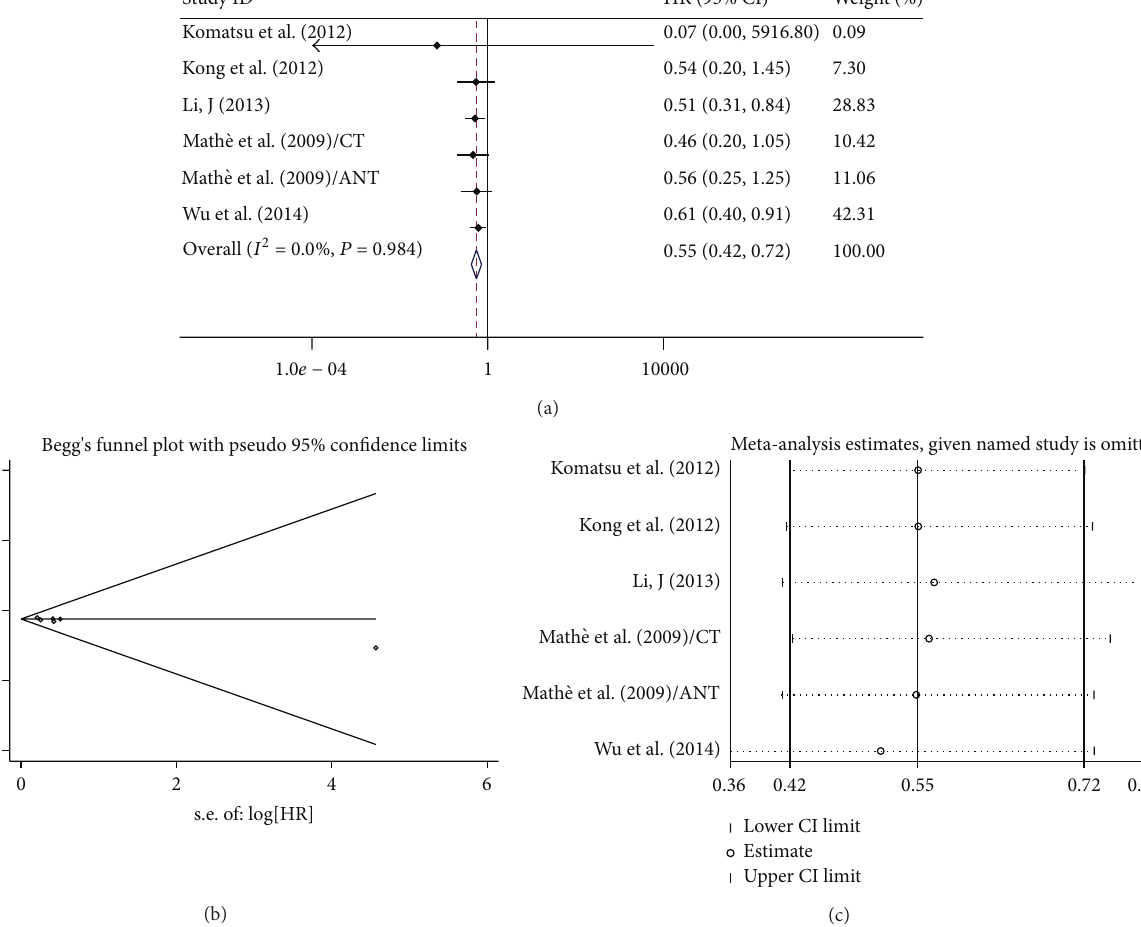
Figure 2: (a) Forest plots of studies evaluating hazard ratios (HRs) of high miR375 expression as compared to low expression. (b) Funnel plots of publication bias for meta-analysis of miR-375. (c) Sensitivity analysis for meta-analysis of